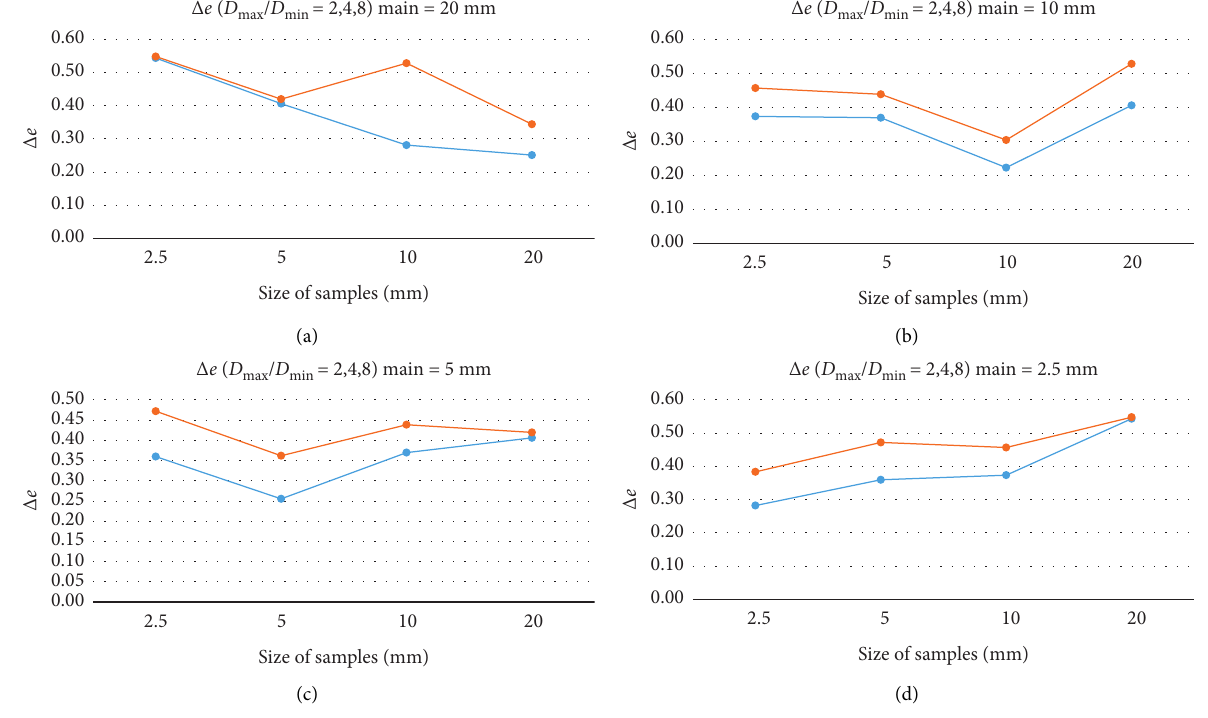
Figure 14: Difference in porosity ratio between loose and dense materials with different granulations by funnel and spoon precipitation method (weight installation of aggregates, aggregates with sizes of 2.5, 5, 10, and 20mm).